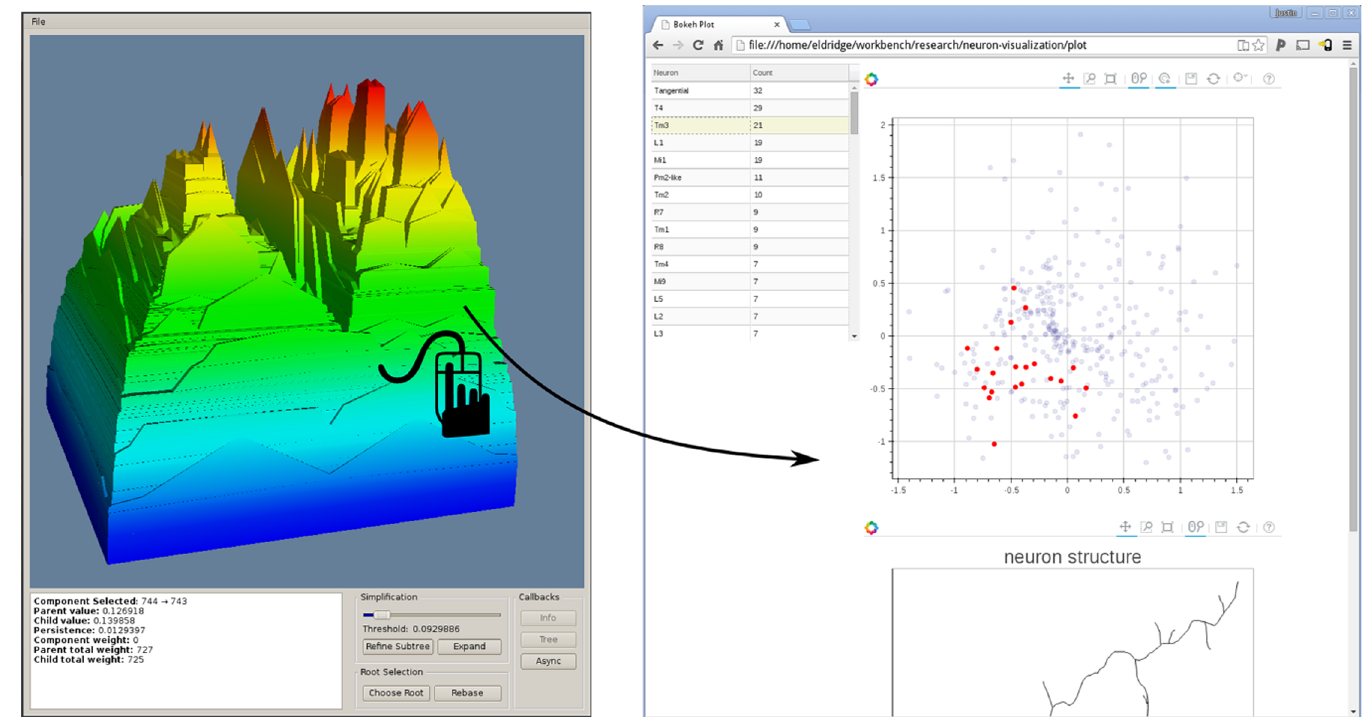
Fig 10. Terrain metaphor exploration tool for HCT. As a user selects a regionin the terrain, the HCT view and embedding view are shown on the right. One can further select a neuronfrom the HCT / 2D embedding view, and inspects its structure as well as associatedL-Measure information.